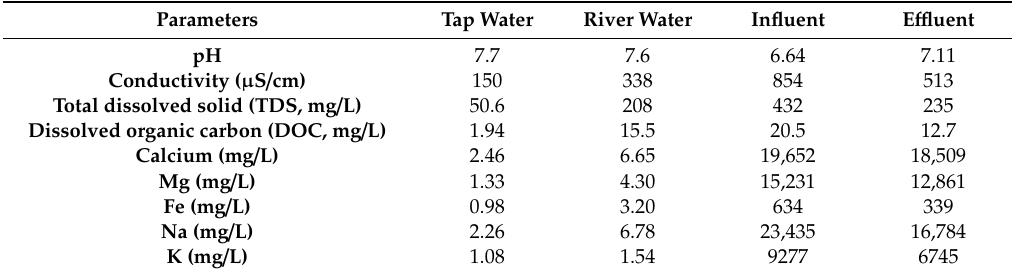
Table A1. Physicochemical properties of water